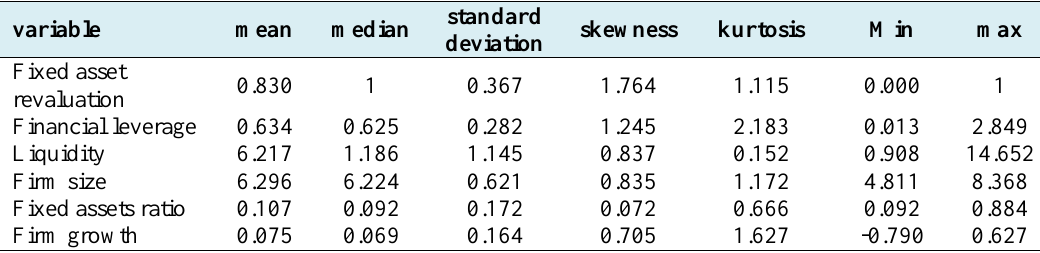
Table 2. Descriptive statistics of research variables of companies listed on the TSE during the period 2015-